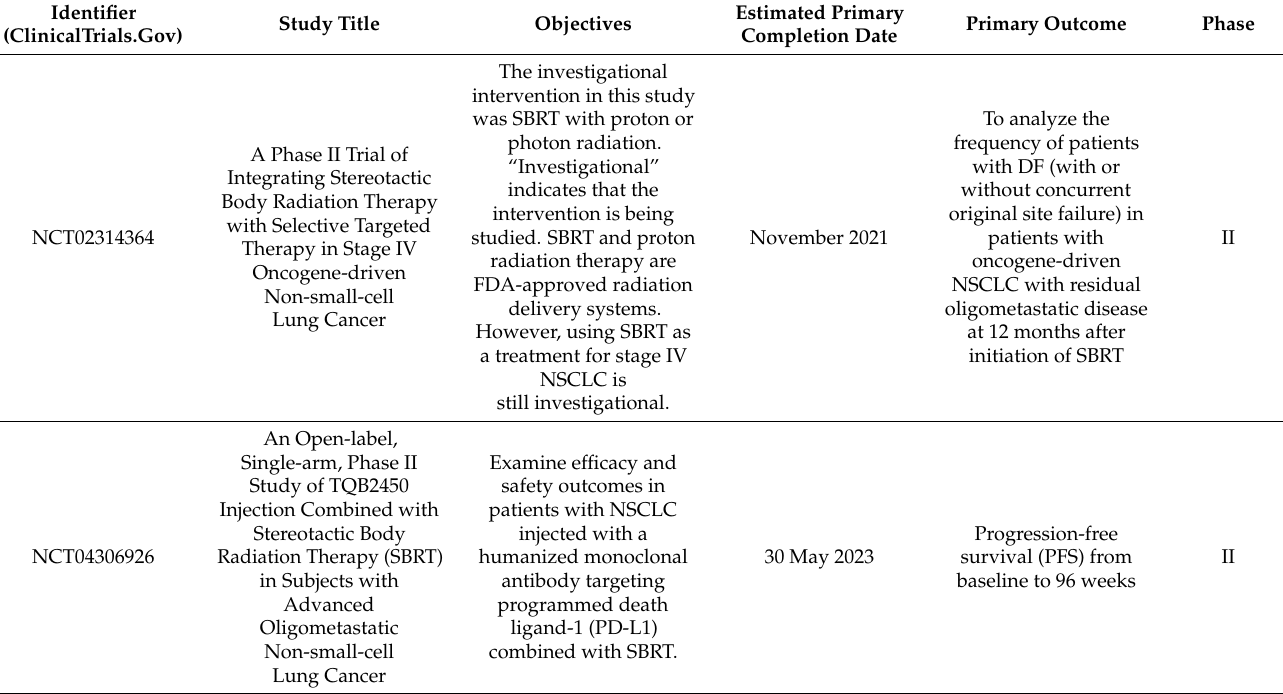
Table 2. Ongoing trials of SBRT in patients with NSCLC